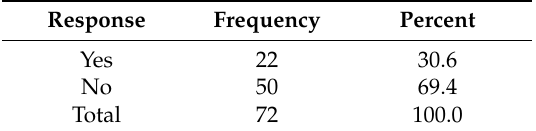
Table 2. The response on awareness of the procedure for filing civil suits against the